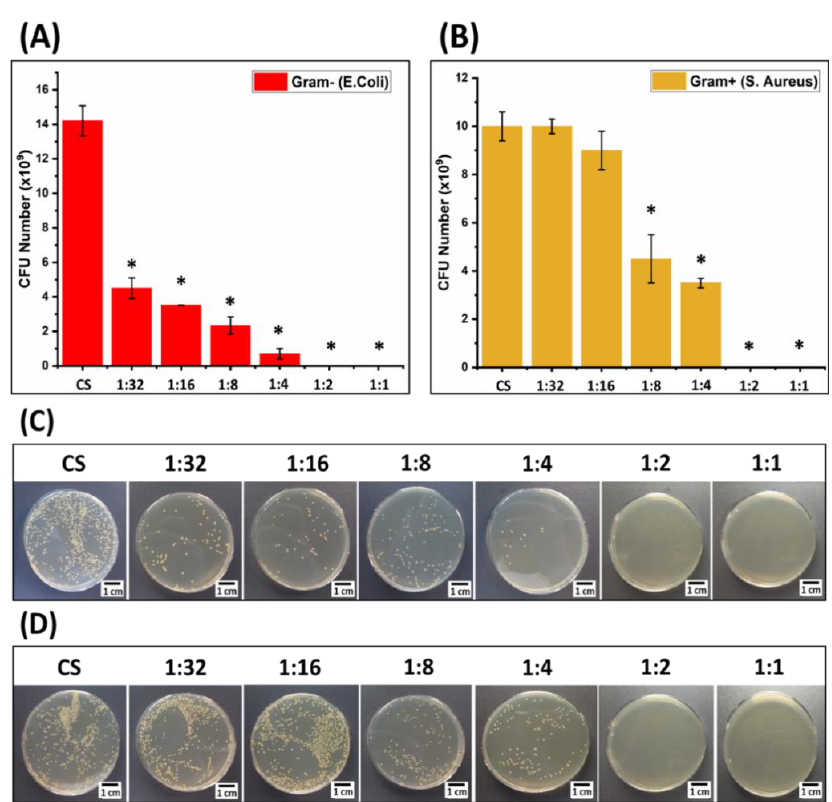
Figure 6. Colony forming unit (CFU) measurement of CS and Ga (III)-CS complex films after 24 h of incubation in LB medium in contact with ( A ) E. coli and ( B ) S. aureus (statistical analysis was performed with respect to pure CS samples). Photograph of the CFU of ( C ) E. coli and ( D ) S. aureus after 24 h of incubation in the presence of CS and Ga (III)-CS complexes. Significant differences are represented by an asterisk (*).